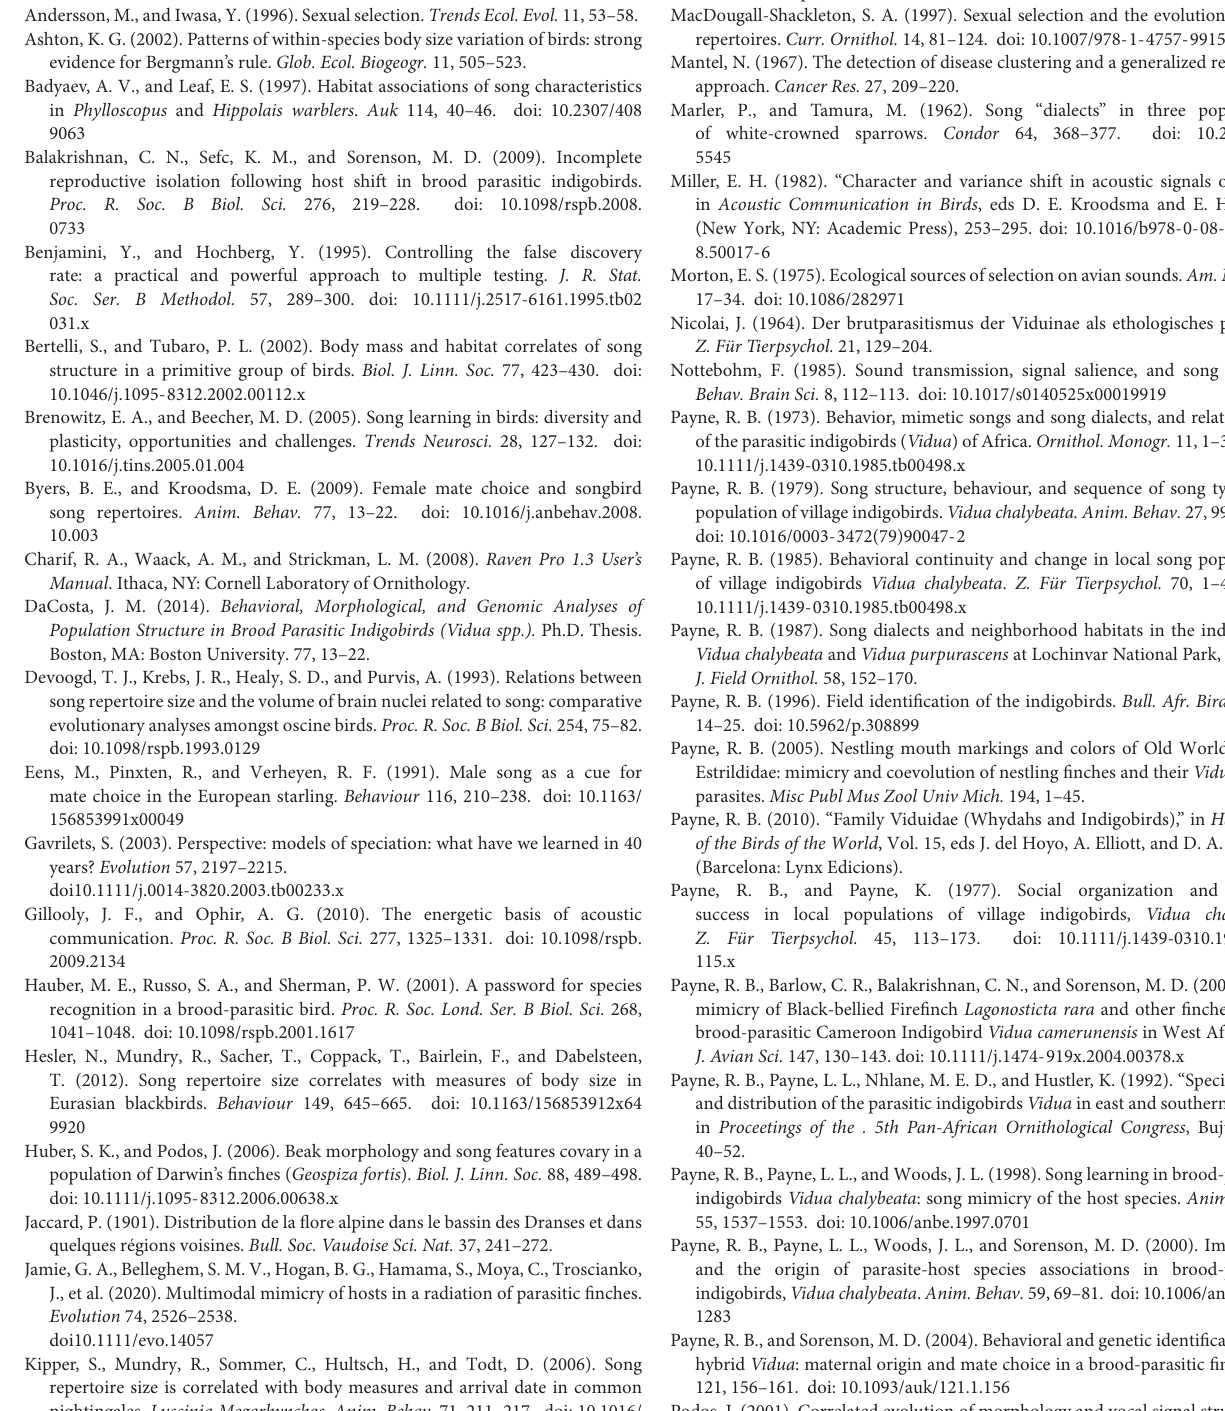
Supplementary File 3 | DaCostaSorenson_PCA_results.xlsx. Results (rotations, importance of components, and eigenvalues) for PCA analyses of